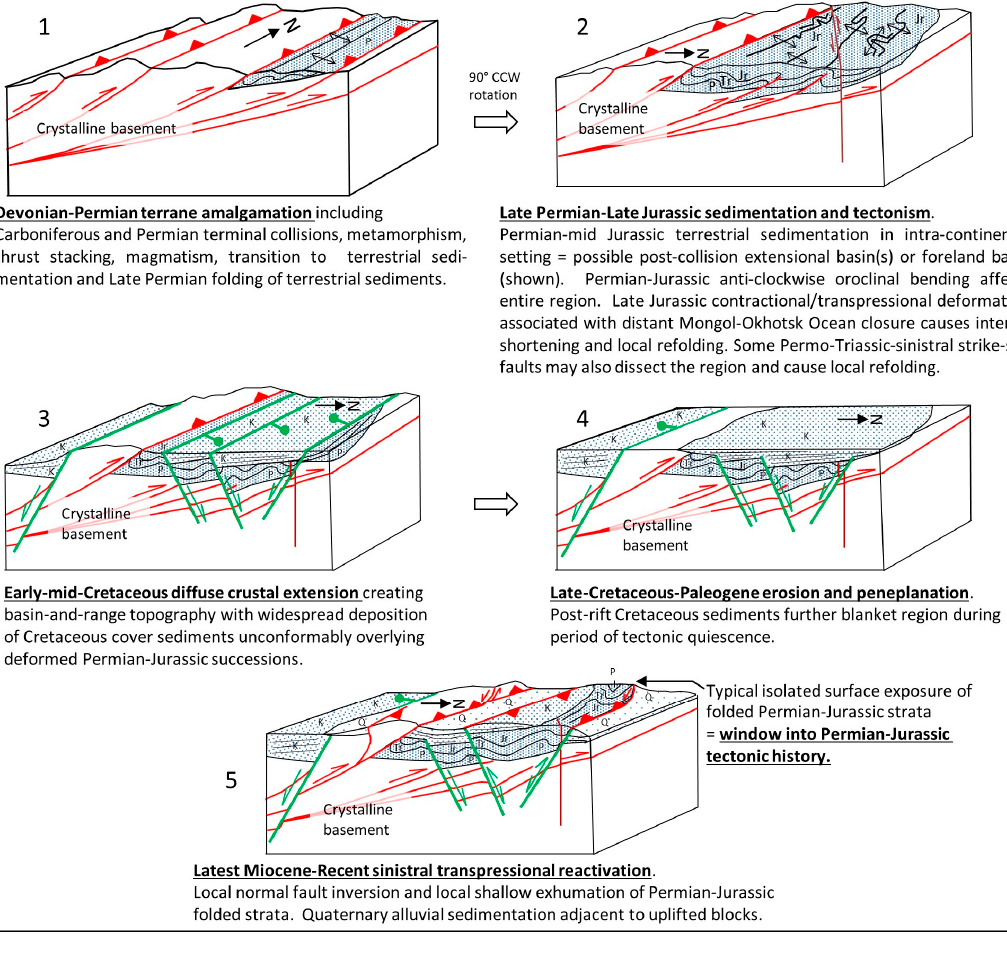
Figure 16. Block model showing five stages of crustal evolution responsible for typical structural/stratigraphic relationships within folded basinal compartments in the southernmost Gobi Altai region, Mongolia. Stage 1 involved Devonian-Triassic terrane consolidation, progressive crustal shortening, mountain building, metamorphism and magmatic additions to the crust (not shown), progressive erosion and terrestrial sedimentation, and folding of eroded sediments in Permian foreland. Stage 2 involved Late Permian-Triassic-mid-Jurassic erosion and deposition of thick terrestrial sediments that were subsequently north-south shortened into a Late Jurassic fold-and-thrust belt. Left-lateral strike-slip faults also cut the region during this stage and may cause some refolding of Permian strata [26]. Stage 3 involved diffuse crustal extension during the early-mid Cretaceous that created basin and range-type compartmentalized rift basins and deposition of widespread alluvial sediments that unconformably overlapped the older deformed Permian-Jurassic strata [30,34]. Stage 4 involved Late Cretaceous-Miocene tectonic quiescence and erosion, sedimentation, and peneplanation of the landscape ([15,34], and references therein). Stage 5 involved Miocene-Recent sinistral transpressional reactivation of the Gobi Altai region creating a transpressional basin and range landscape and overprinting to variable degrees all previous deformation events [15,31]. Uplifted and eroded basinal areas in scattered localities in the southern Gobi Altai region reveal folded Permian-Jurassic strata that remain buried elsewhere.